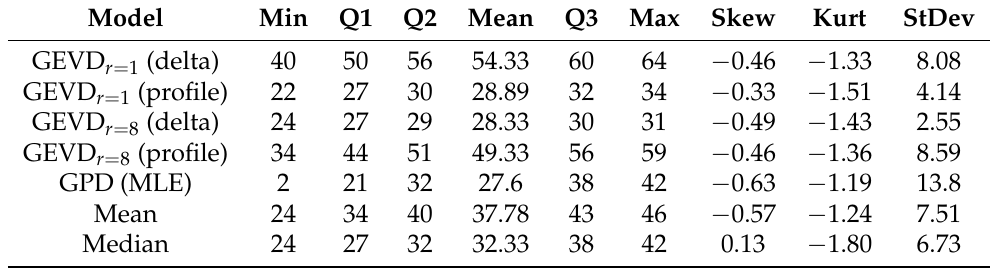
Table 4. Summary statistics for PIW (PINC 95%).